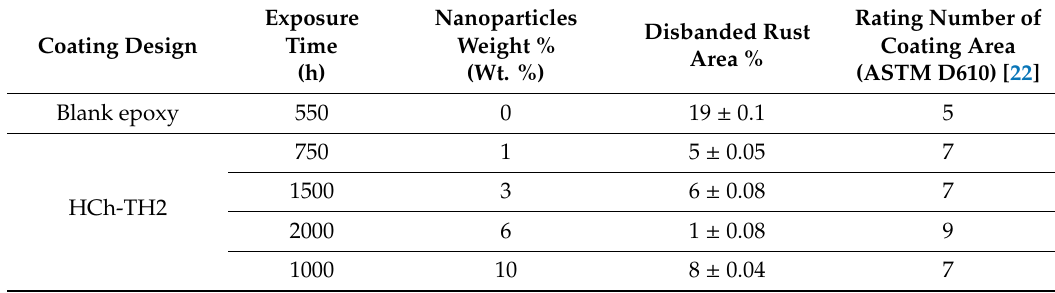
Table 3. Salt spray resistance of DGEB / PA epoxy coating films at di ff erent Ch-TH2 loading after exposure to salt spray fog at di ff erent